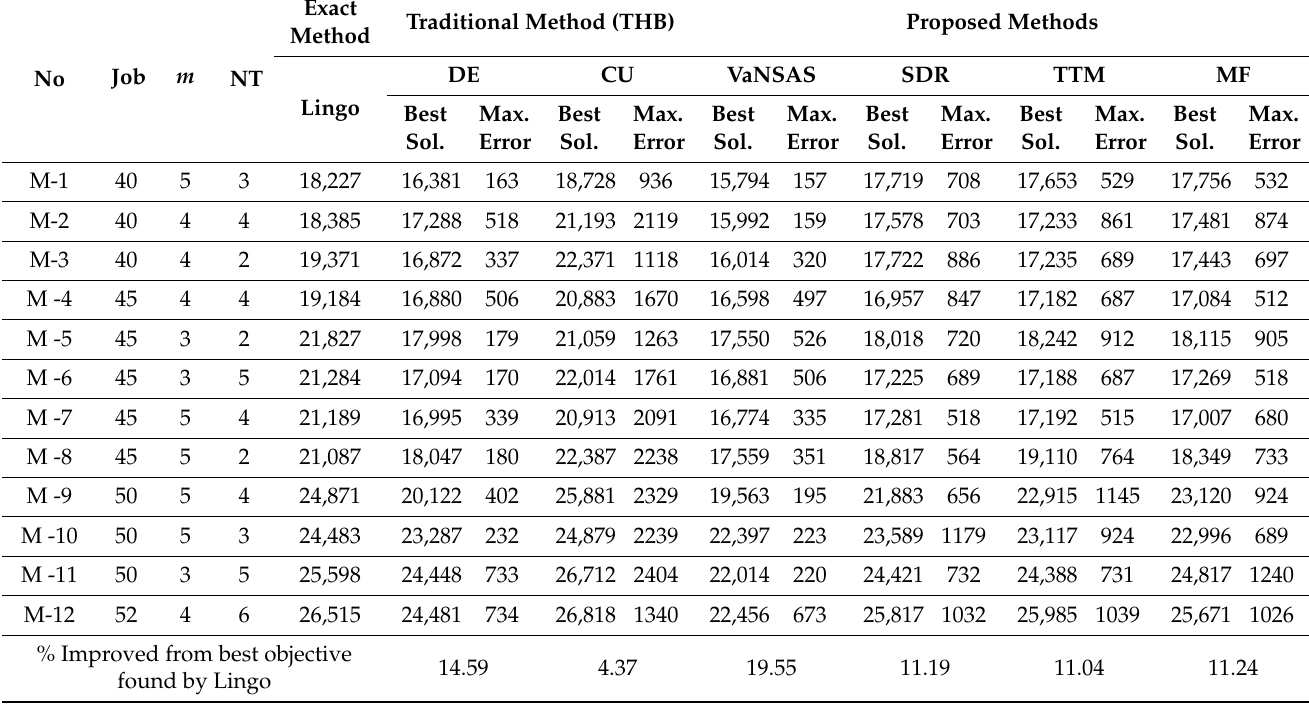
Table 11. Computation results of medium-sized test instances.